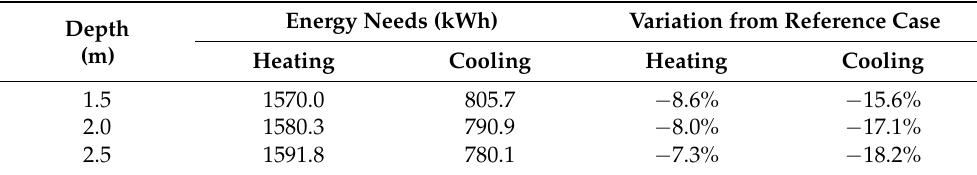
Table 5. Building’s annual energy needs and percentage change relative to the reference case varying sun space’s